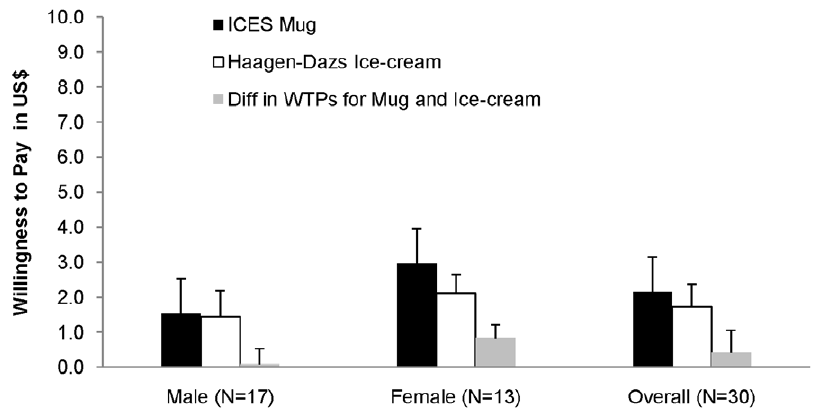
Figure 1. Willingness-to-pay (WTP) for ICES Mug and Haagen-Dazs Ice-cream. The Fig. describes males’ and females’ WTP for the ICES Mug (filled black bars), the Haagen-Dazs Ice-cream (open bars), and the differences between them (filled grey bars). WTPs are statistically identical between males and females for both the mug (z=1.593, P=0.111) and the Ice-cream bar (z=1.418, P=0.156). WTPs are also statistically identical within the same gender for the two items (Wilcoxson signed-rank test: for male, z=0.049, P=0.961; for female, z=0.956, P=0.339, two-tailed). The differences in WTP for Mug and Ice-cream are also statistically identical between males and females (z=0.727, P=0.467).